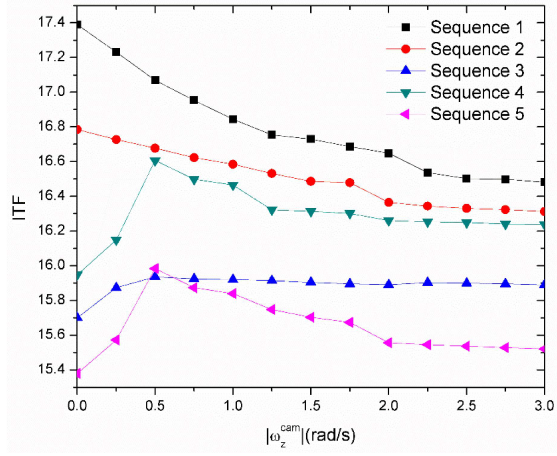
Figure 10. Inter-frame transformation fidelity (ITF) of video sequences with different switch threshold rotation